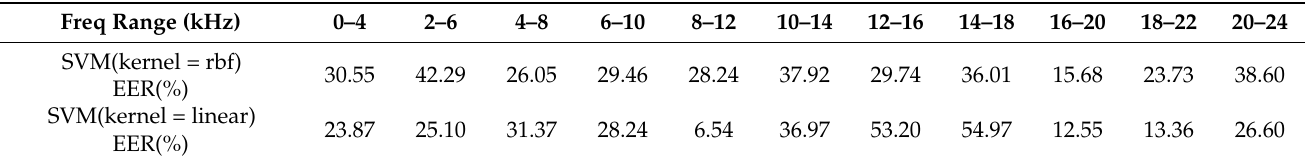
Table 4. The performance among each frequency range.